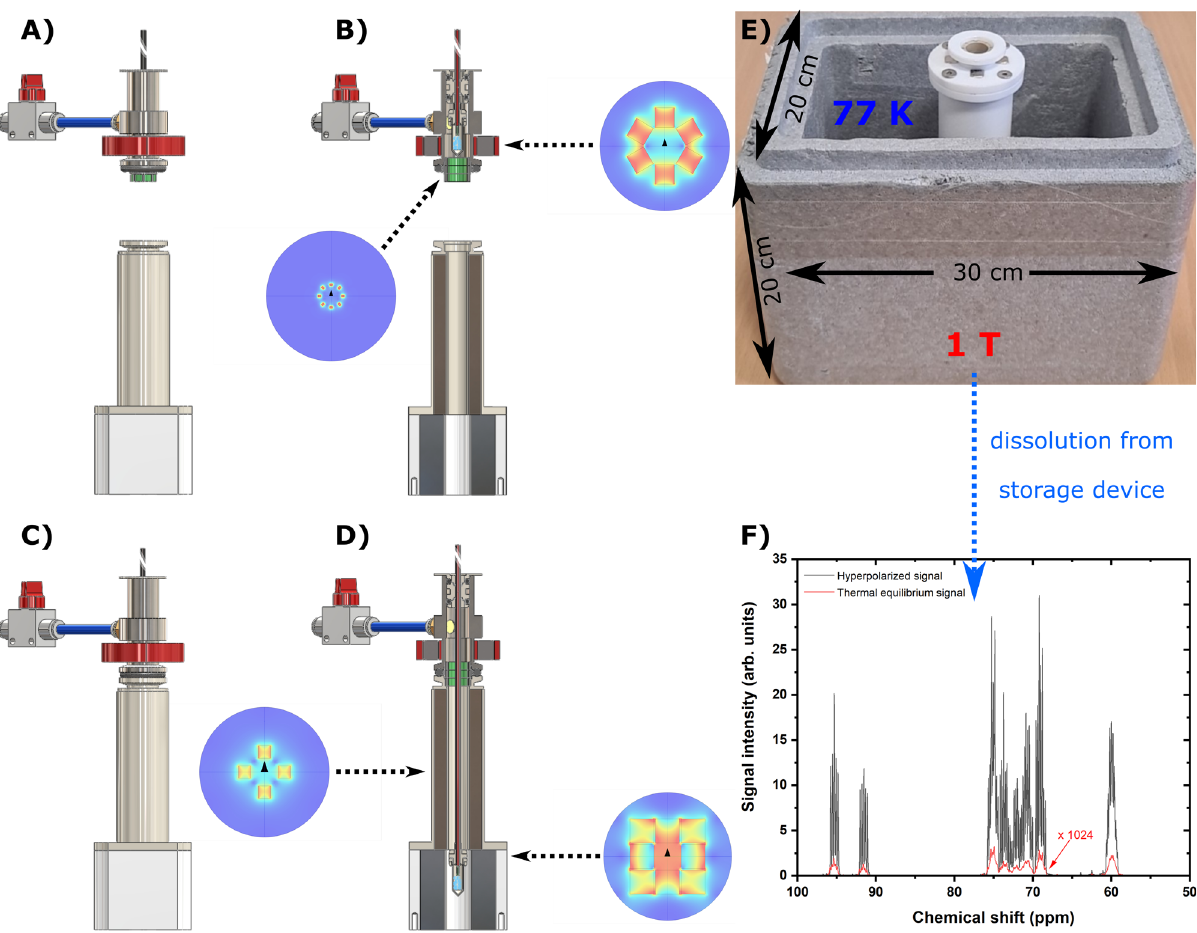
Fig. 5 HP solid transport and remote dissolution. We report here a schematic of our strategy for storage/transport of a HP sample and remote dissolution. After lifting up the sample vial above the gate valve, the transport procedure entails four main steps. First, the loading chamber/air lock is disconnected from the polarizer and docked to the transport device ( A ) and ( B ). Second, the sample vial is pushed down to reach the 1 T magnet ( C ) and ( D ). The transport device is composed by two parts: a four elements 300 mT Halbach array magnetic guide at the top and an eight elements 1 T Halbach array storage magnet at the bottom. The transportation device is placed inside a Styrofoam box and plunged in liquid nitrogen ( E ). Third, the Styrofoam box is transported to the site where the dissolution experiment is going to happen. Fourth, the CFP quick release is connected to the dissolution station (see Supporting Material) and the HP solution obtained and transferred to the NMR 9.4 T spectrometer for measurements ( F